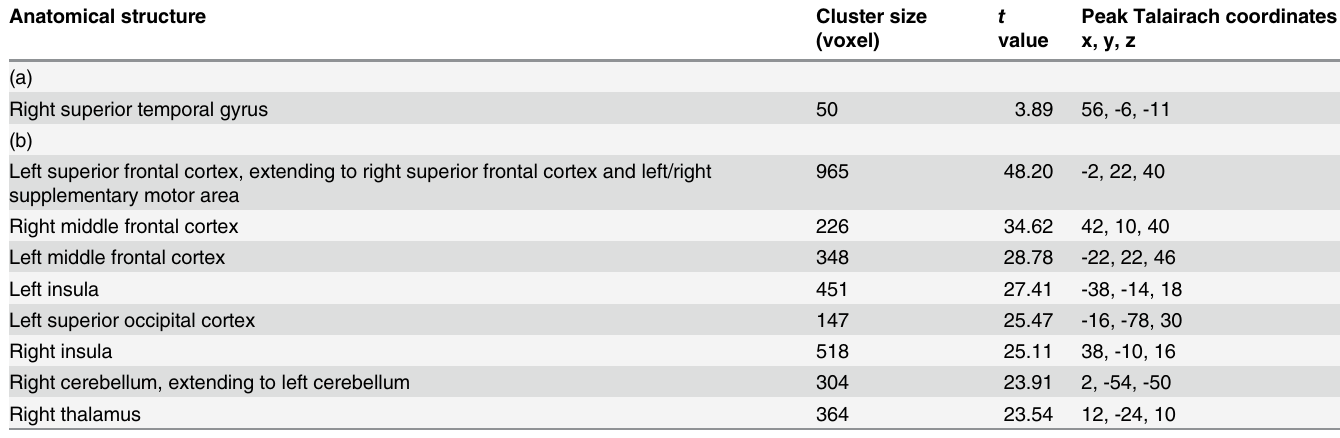
Table 2. Anatomical structures showing significant GM abnormalities (a) decreased GM volume at baseline in patients with schizophrenia (n = 20) compared to healthy controls (n = 24); (b) increased GM volume from baseline to follow-up (8 weeks of treatment) in patients with schizophrenia (n = 9).